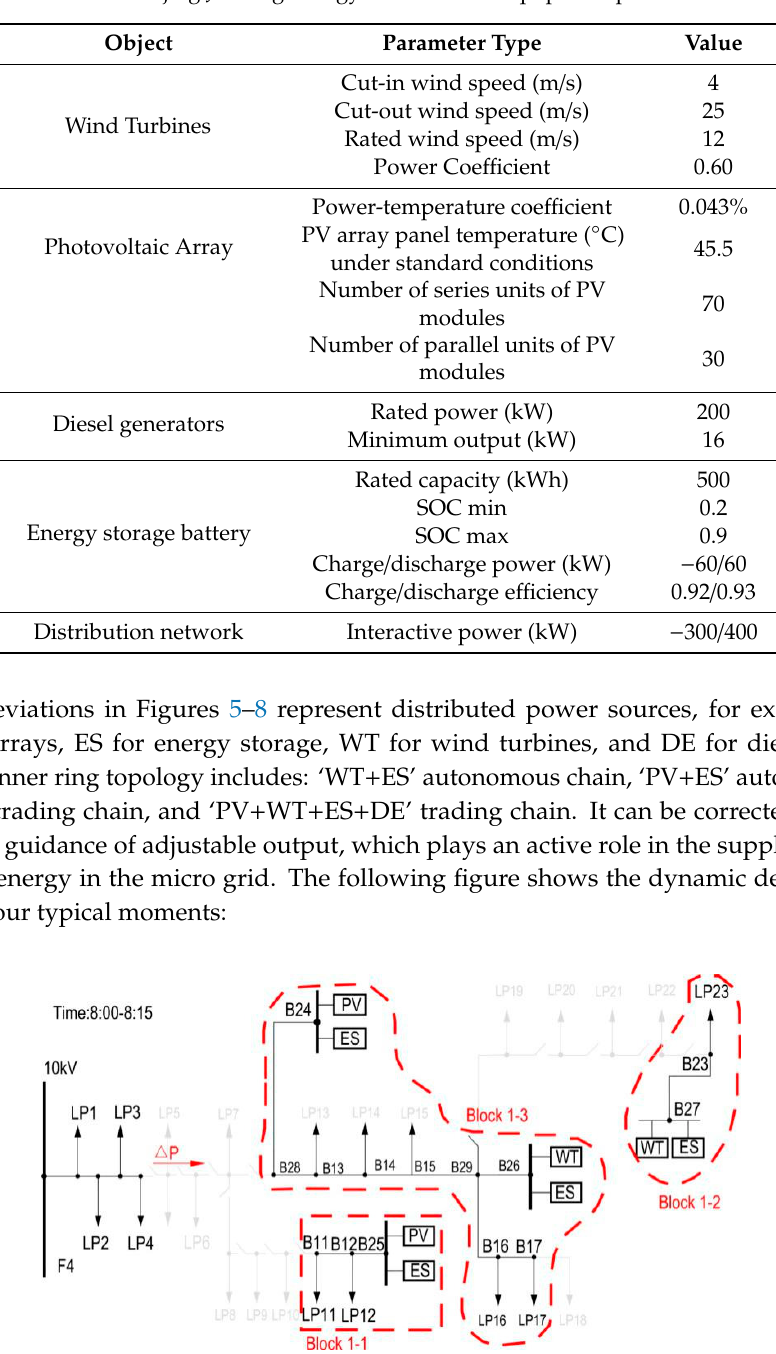
Table 2. Beijing Jin-feng Energy Internet Park equipment parameters.